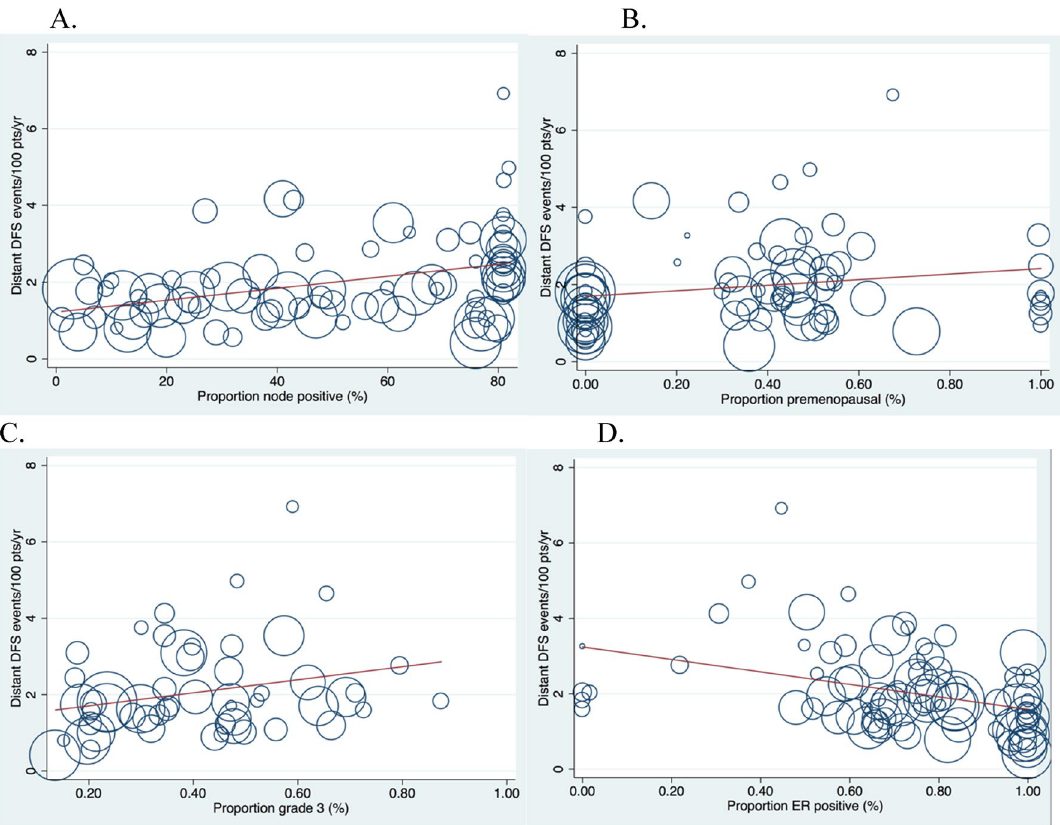
Figure 2. ( A – D ) Distant DFS event rate/per 100 participants/year as a percentage of all participants randomized, stratified by co-variates. ( A ) % of participants node positive (n = 84). ( B ) % pre menopausal (n = 75). ( C ) % grade 3 (n = 53). ( D ) % ER positive participants (n =